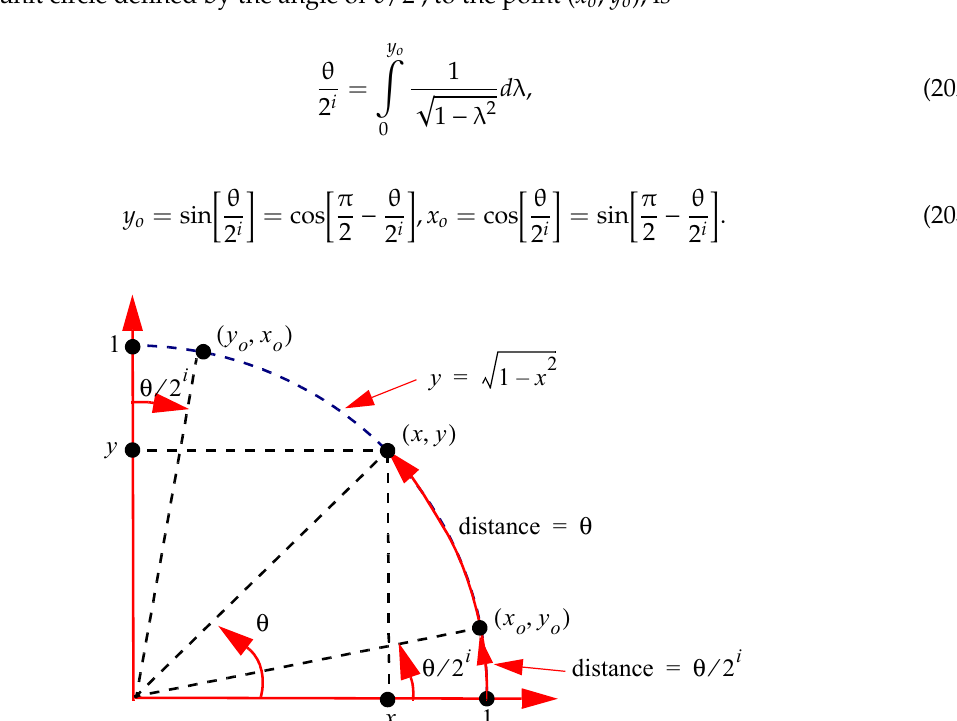
i o , y o ) based on the angle θ /2